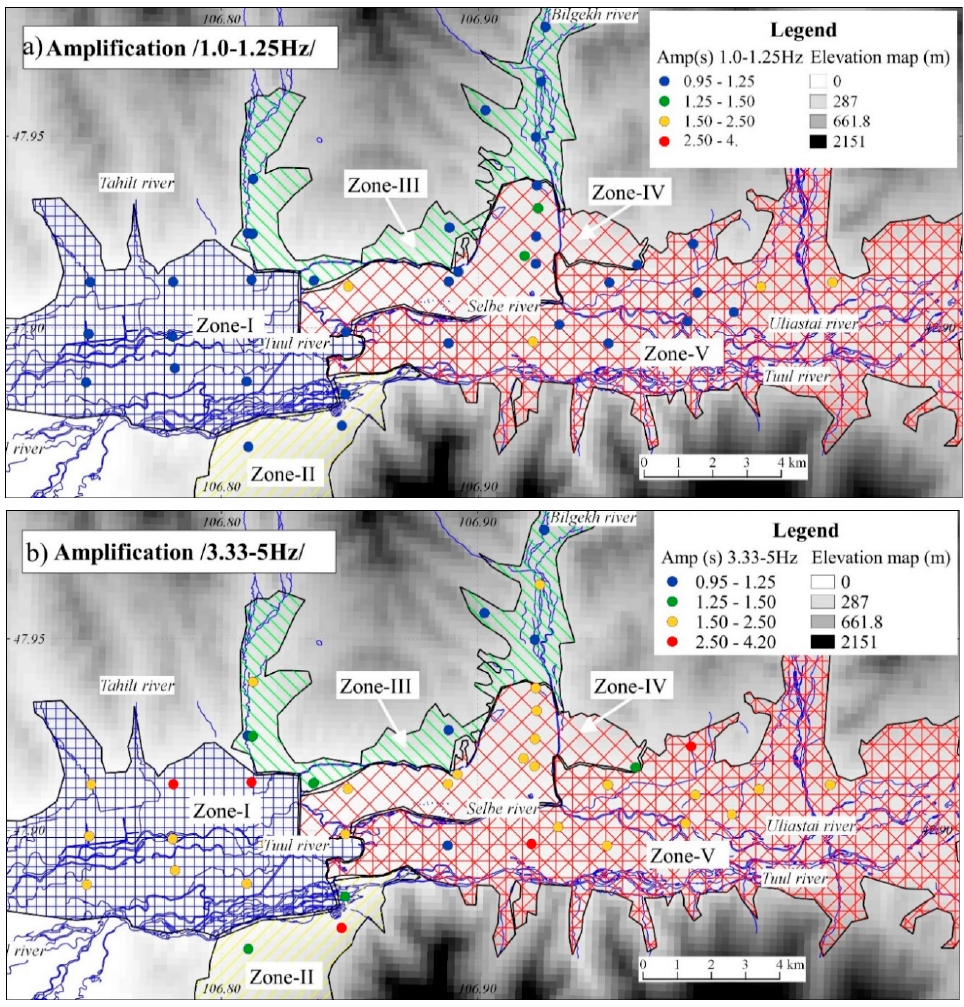
Figure 9. ( a ) V S 30 distribution map with geotechnical map [18]; ( b ) V S 30 distribution map with a digital elevation model